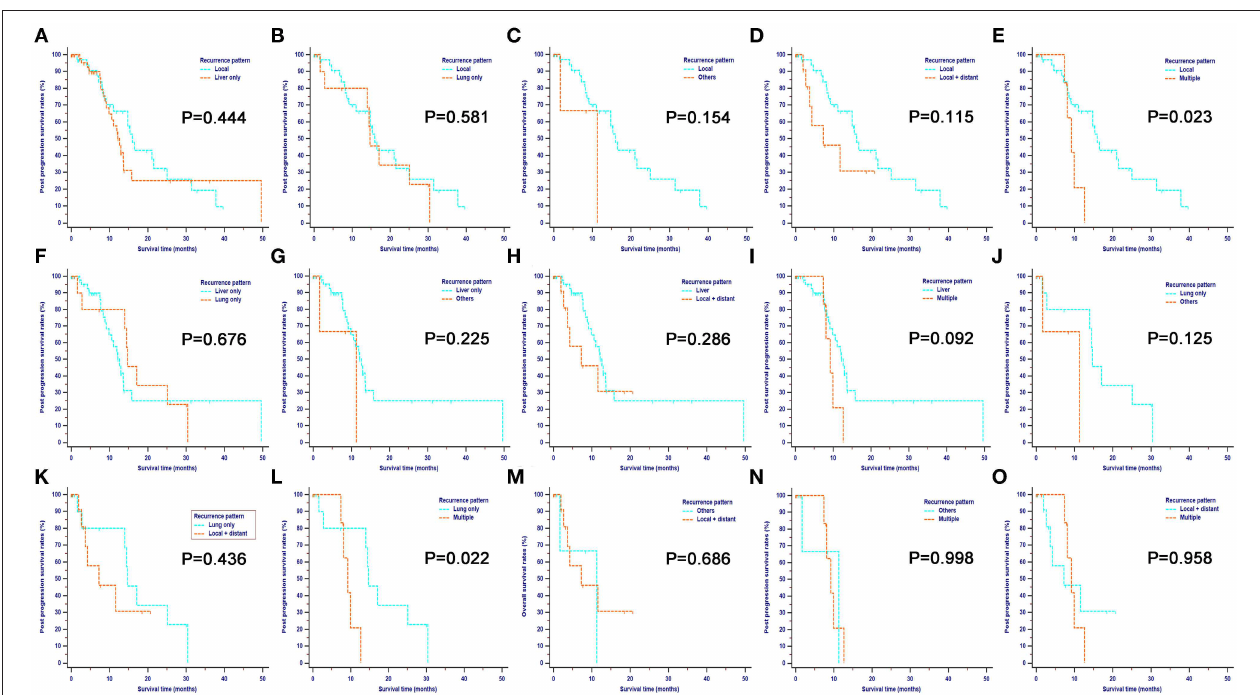
FIGURE 1 | Pairwise comparison of post-progression survival for different tumor progression patterns. Stratification of patients by comparing the following patterns of progression: local vs. liver only (A) ; local vs. lung only (B) ; local vs. others (C) ; local vs. local + distant (D) ; local vs. multiple (E) ; liver only vs. lung only (F) ; liver only vs. others (G) ; liver only vs. local + distant (H) ; liver only vs. multiple (I) ; lung only vs. others (J) ; lung only vs. local + distant (K) ; lung only vs. multiple (L) ; others vs. local + distant (M) ; others vs. multiple (N) and local + distant vs. multiple (O) . Landmark analysis was used to analyze survival differences whose survival curves were crossed. For the comparisons of survival rates between local recurrence and other sites, liver-only metastasis and multiple metastases, lung-only metastasis, and multiple metastases, the former had significantly higher survival rates ( P < 0.05), compared with the latter after 1 year since tumor progression, which was used as the landmark point for survival analyses. Also, patients with local progression had significantly higher survival rates compared with those with multiple analyses while survival rates were similar between other comparison groups. Overall, multiple metastases contributed to the poorest survival among these progression patterns.